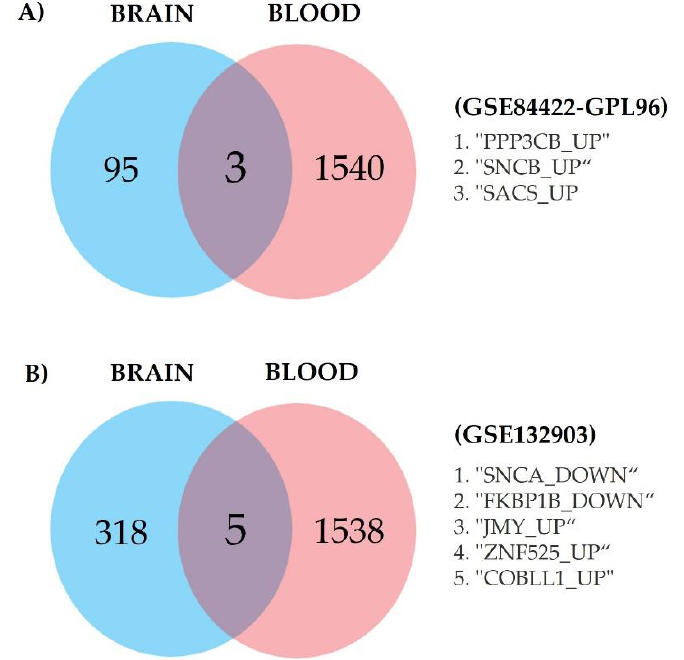
Figure 8. Venn diagram of overlap between genes from differential expression analysis and weighted gene correlation network analysis for AD phenotype (DEGs+WGCNA), previously reported differen- tially expressed genes, and list of mapped genes obtained from genomewide association studies (AD GWAS); intersection ( ∩ ). ( A ) GSE97760 ∩ GSE84422-GPL96; ( B ) GSE97760 ∩ GSE132903.